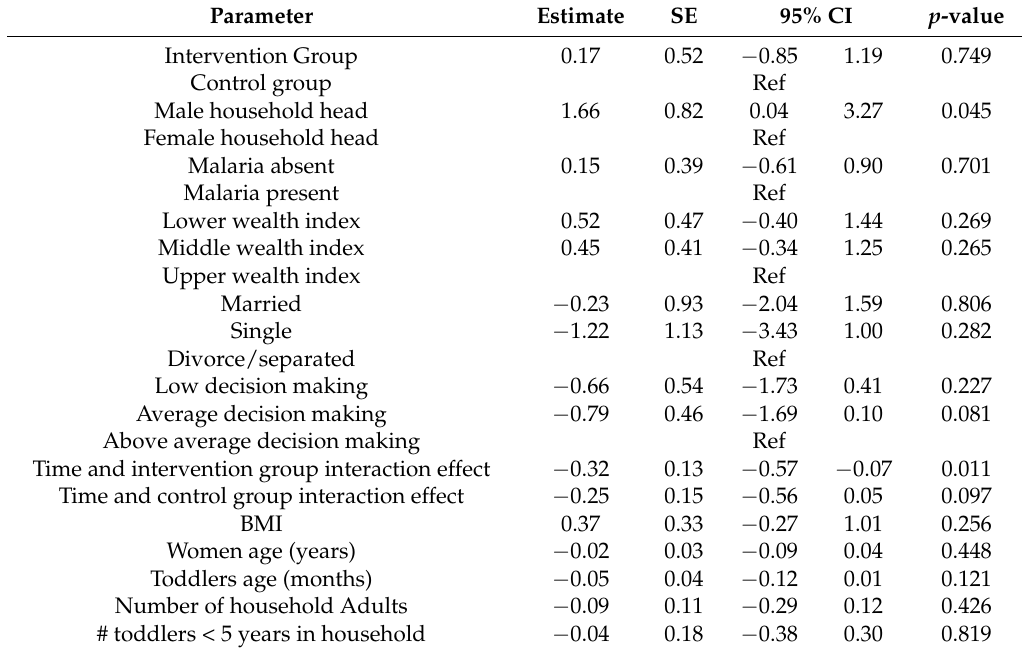
Table 4. Comparison of iron deficiency among childbearing age women (15–49 years.) in intervention and control groups across